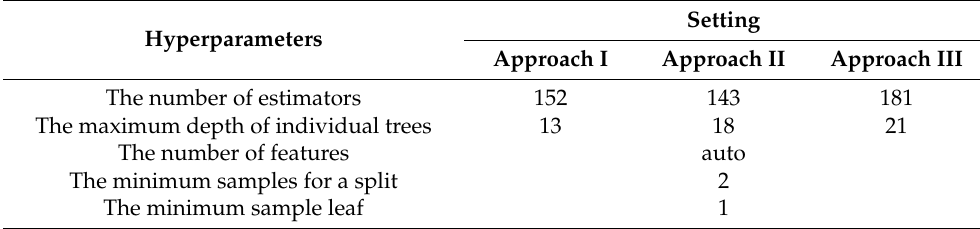
Table 2. The RF-optimized hyperparameter setting for three approaches.